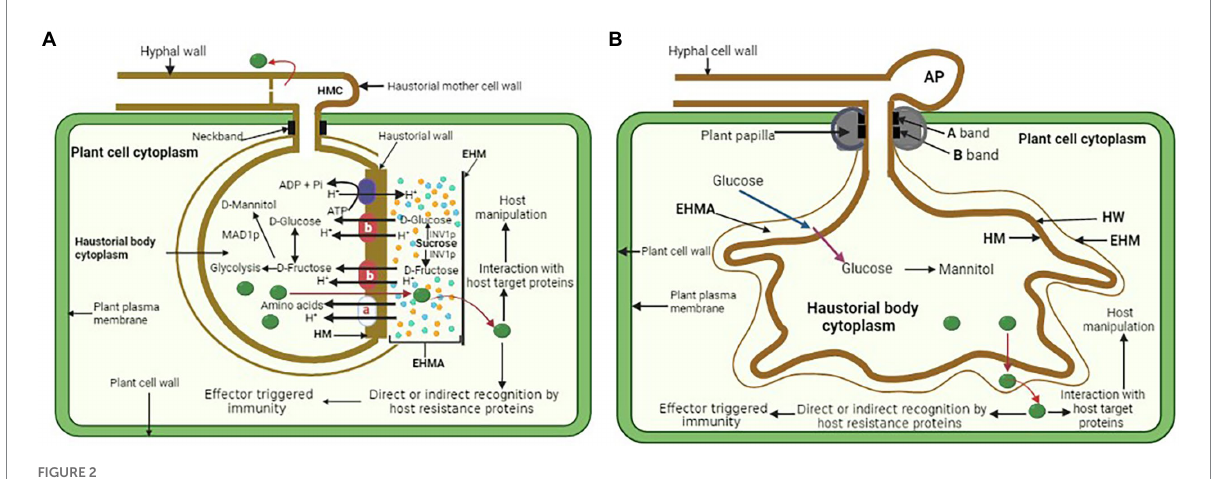
FIGURE 2 (A) General illustration of a rust fungus (dikaryon) haustorium and a proton symport model for the active uptake of amino acids and hexoses and redistribution from an infected leaf cell into a rust haustorium. EHMA, extrahaustorial matrix; EHM, extrahaustorial membrane; HM, haustorial plasma membrane. Haustorial plasma membrane H1-ATPase drives the uptake of nutrients by supplying protons. a —amino acid transporters AAT1 and AAT2; b —hexose transporter HXT1. Symport carriers utilize the resulting proton gradient between EHMA and haustorial cytoplasm to actively uptake amino acids and sugars. (B) General illustration of powdery mildew haustorium and its functions. HW, haustorial cell wall. Glucose passes through the EHM by facilitated diffusion (blue arrow) into EHMA where it is then actively transported (purple arrow) through the HM into the haustorial body cytoplasm. The glucose in the haustorium is converted to mannitol and then moves out to facilitate further mycelium growth. Both rust fungi and powdery mildew haustorium also secrete effectors (green) into the apoplast, including the EHMA and may pass through the EHM before entering the cytoplasm of the host plant where they are directly or indirectly recognized by the host disease resistance proteins resulting in effector triggered immunity, or they may target host proteins to manipulate host